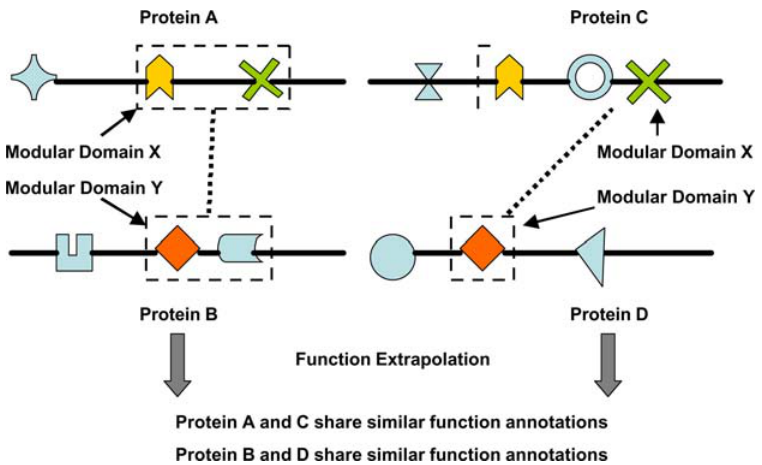
Figure 1. Function annotation scheme based on interacting domain patterns. This also illustrates how domain interaction can contribute to protein interactions. One or more domains in a protein may form modular domains and interact with other modular domains in other proteins. Dashed rectangles represent modules. In each module, one or more domains may exist and form a unit during interaction. The dashed lines represent interactions between proteins. Since the protein-protein interaction pairs A–B and C–D share common domain interaction patterns, and proteins A and C and B and D share the same interacting modular domains, we may deduce that the proteins are associated with similar functional annotations.